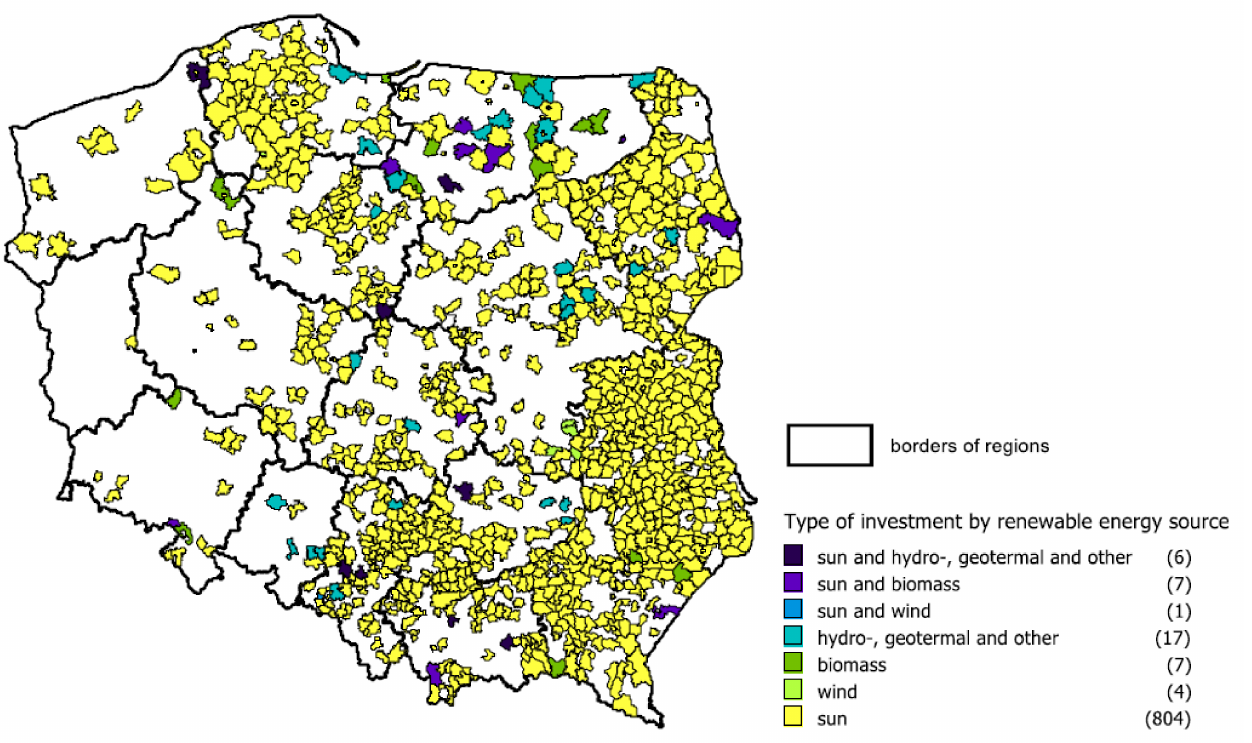
Figure 1. Location of renewable energy projects carried out by local authorities under operational programs 2007–2013, by the source of renewable energy.